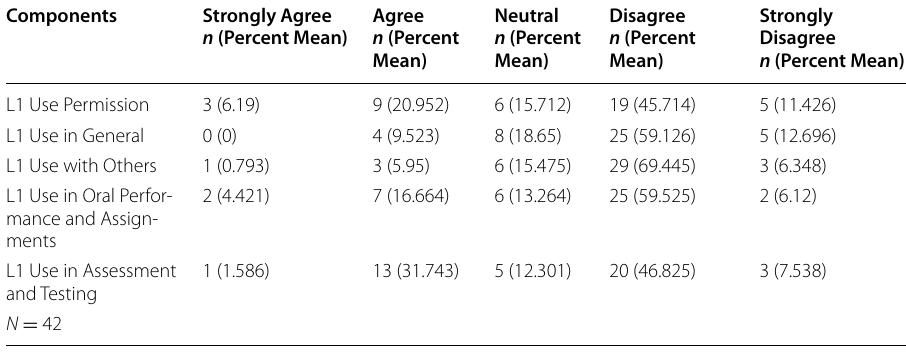
Table 16 Percent Mean for the Five Categories of the L1 Perceptions